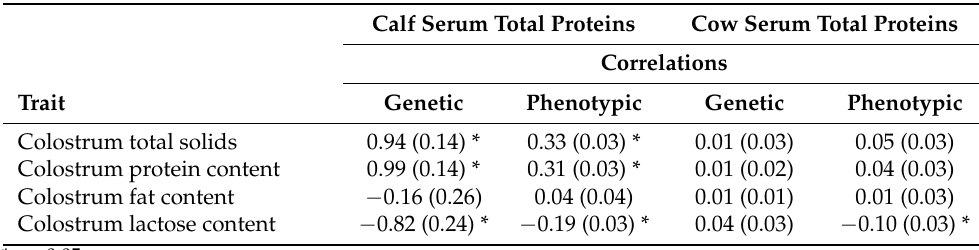
Table 4. Genetic and phenotypic correlations of cow and calf serum total proteins (%Brix value) with colostrum traits (SE in